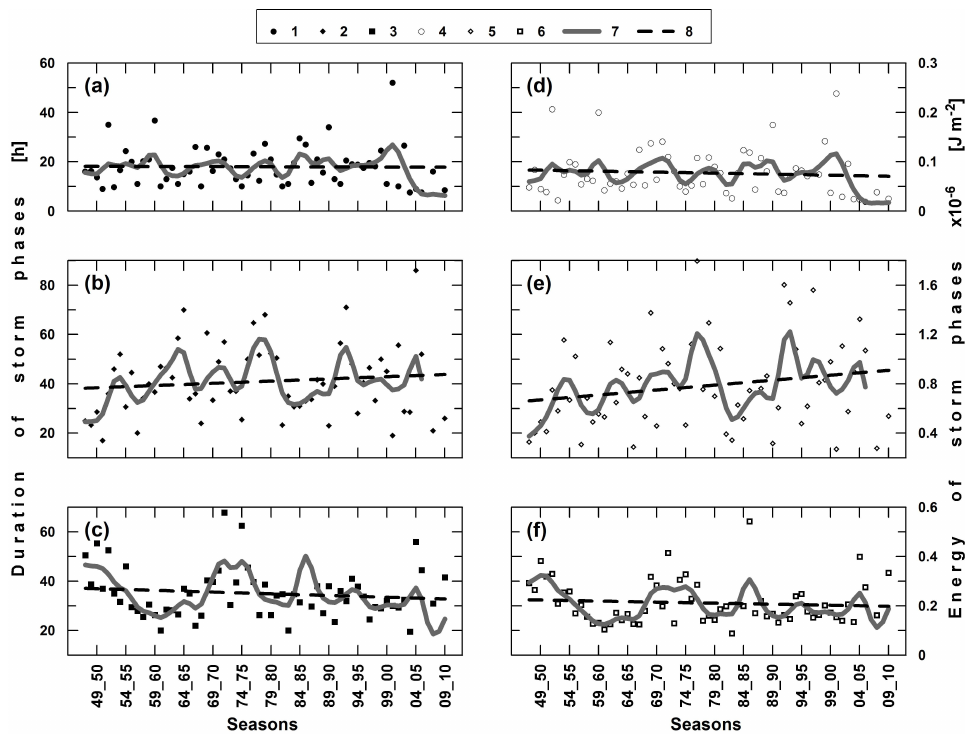
Fig. 12. Variability of average duration and wave energy of storm phases during 1948–2010; (a) Growth phase duration: 1 – data points, 7 – LPF approximation, 8 – global linear trend ( − 0.05 hdecade − 1 , R 2 = 0 . 0002); (b) Duration of the developed sea phase: 2 – data points, 7 – LPF approximation, 8 – global linear trend (0.9hdecade − 1 , R 2 = 0 . 012); (c) Decay phase duration: 3 – data points, 7 – LPF approximation, 8 – global linear trend ( − 0.7hdecade − 1 , R 2 = 0 . 016); (d) Growth phase wave energy: 4 – data points, 7 – LPF approximation, 8 – global